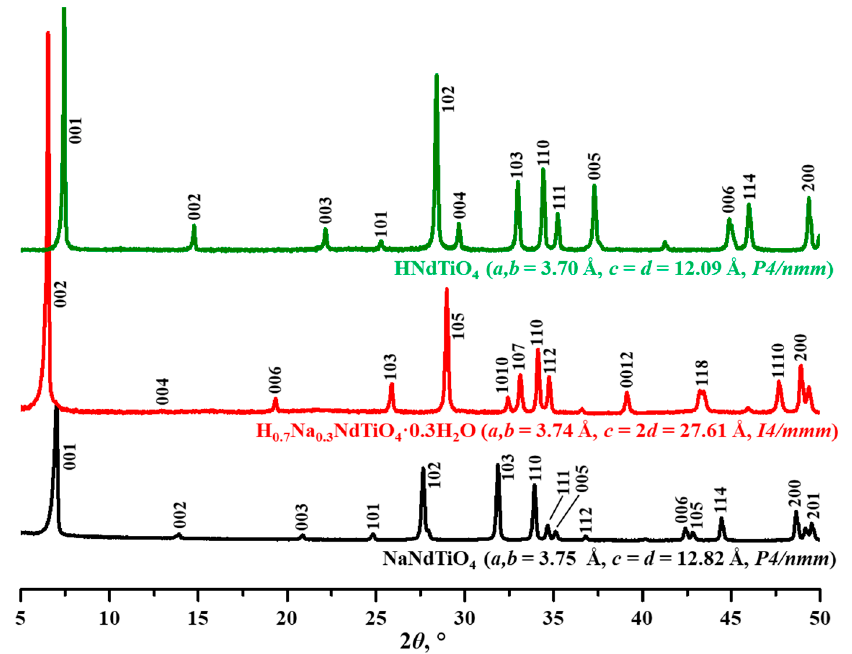
Figure 1. X-ray diffraction (XRD) patterns of the HNdTiO 4 , H 0.7 Na 0.3 NdTiO 4 · 0.3H 2 O and NaNdTiO 4 samples.